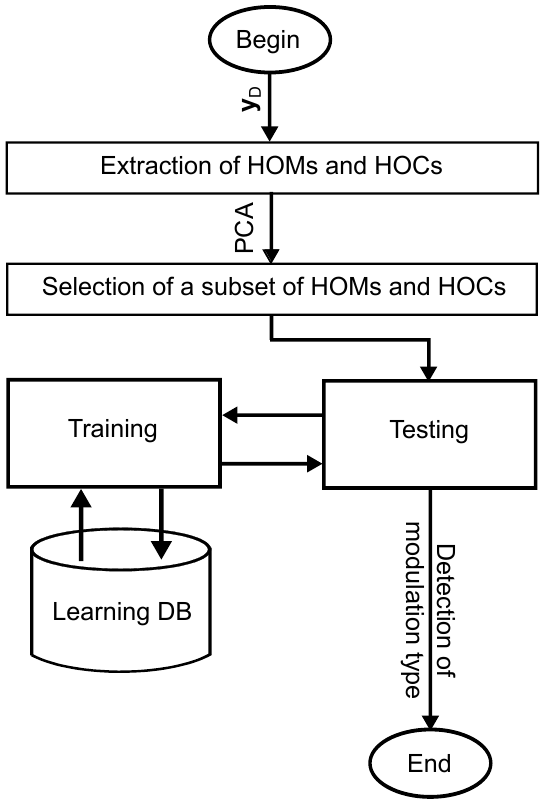
Figure 2. Modulation detection of a given y D